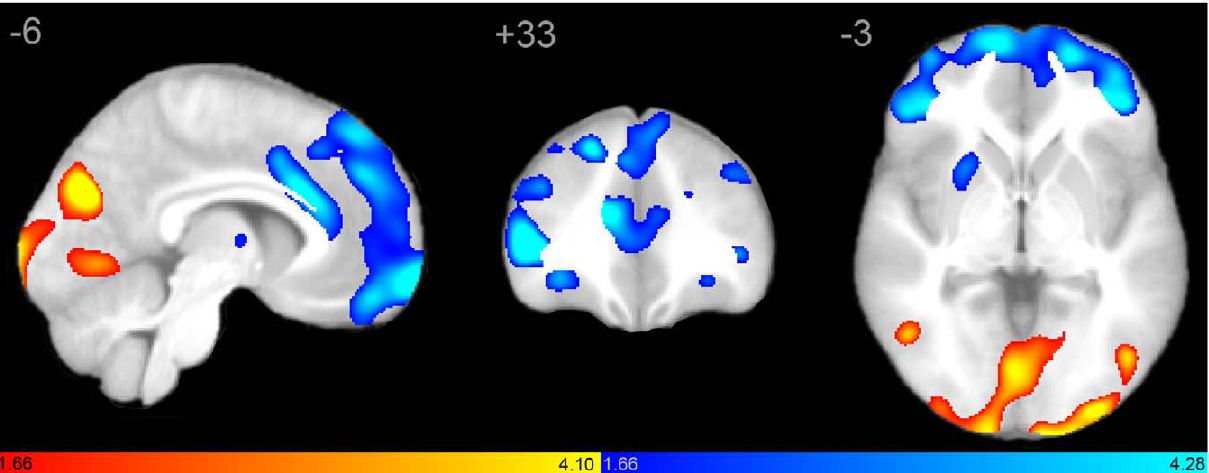
Figure 5. Whole brain structural covariance with ADOS-SI scores as a result of direct between-group contrasts. Statistical parametric maps depict brain regions in which gray matter intensity covaried with ADOS Social Impairment (ADOS-SI) score differently between groups. In controls, ADOS-SI scores covaried with frontal regions overlapping with SN including medial frontal wall, anterior cingulate, and frontoinsular cortex. In contrast, in autistic subjects ADOS-SI covaried with posterior brain regions including cuneus, precuneus, parieto-occipital regions, and temporoparietal cortex. scMRI data are T-statistic maps (p , 0.05, inclusively masked to the network global map for both groups at p , 0.01 FWE) displayed on the average anatomical template of all subjects. scMRI maps from both groups overlaid on a single anatomic volume reveal distinct between-group differences. The left side of the image corresponds to the right side of the brain. SN, salience network. doi:10.1371/journal.pone.0049172.g005 PLOS ONE |